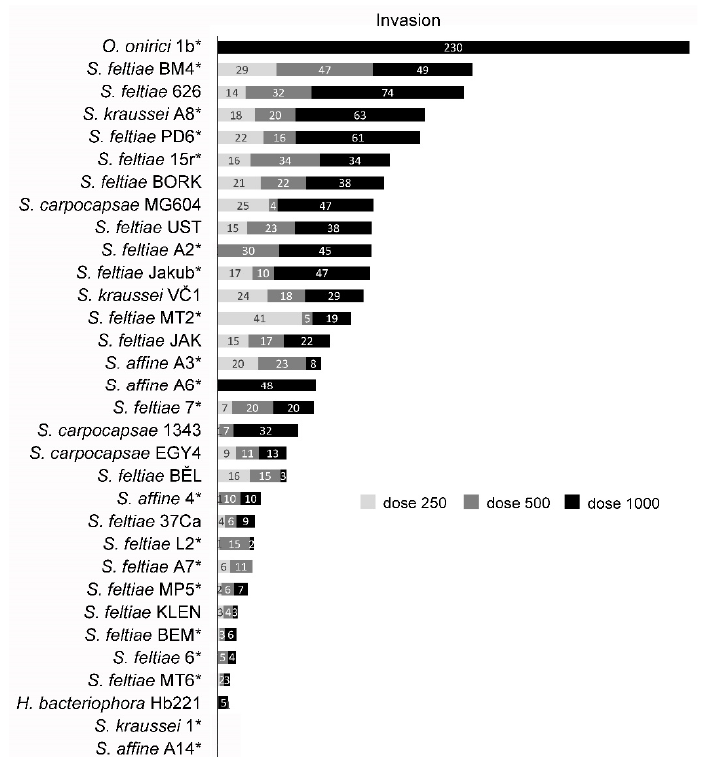
Figure 2. Mean numbers of nematodes of various EPN species and strains that invaded in adult Colorado potato beetles. The nematodes were applied at three doses of 250, 500, and 1000 IJs per host. Endemic strains isolated within this study are marked (*).